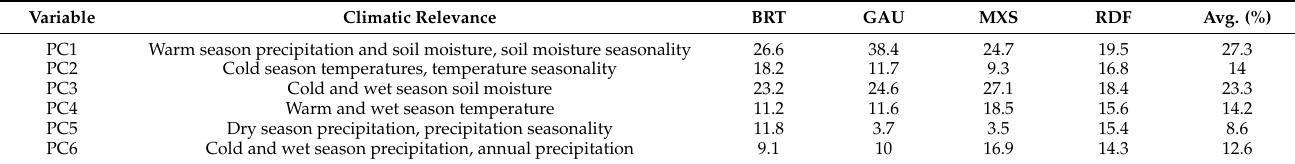
Table 4. The percent contribution of each principal component (PC) variable to correlative models produced by four algorithms. The climatic relevance of each variable (based on which bioclimatic variables had the largest loadings (positive or negative, Table 2)) and average of contributions across all algorithms is